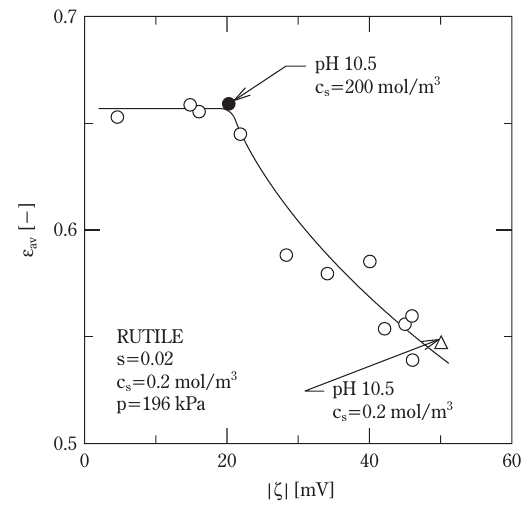
Fig. 17 Relation between average porosity of filter cake and absolute value of zeta